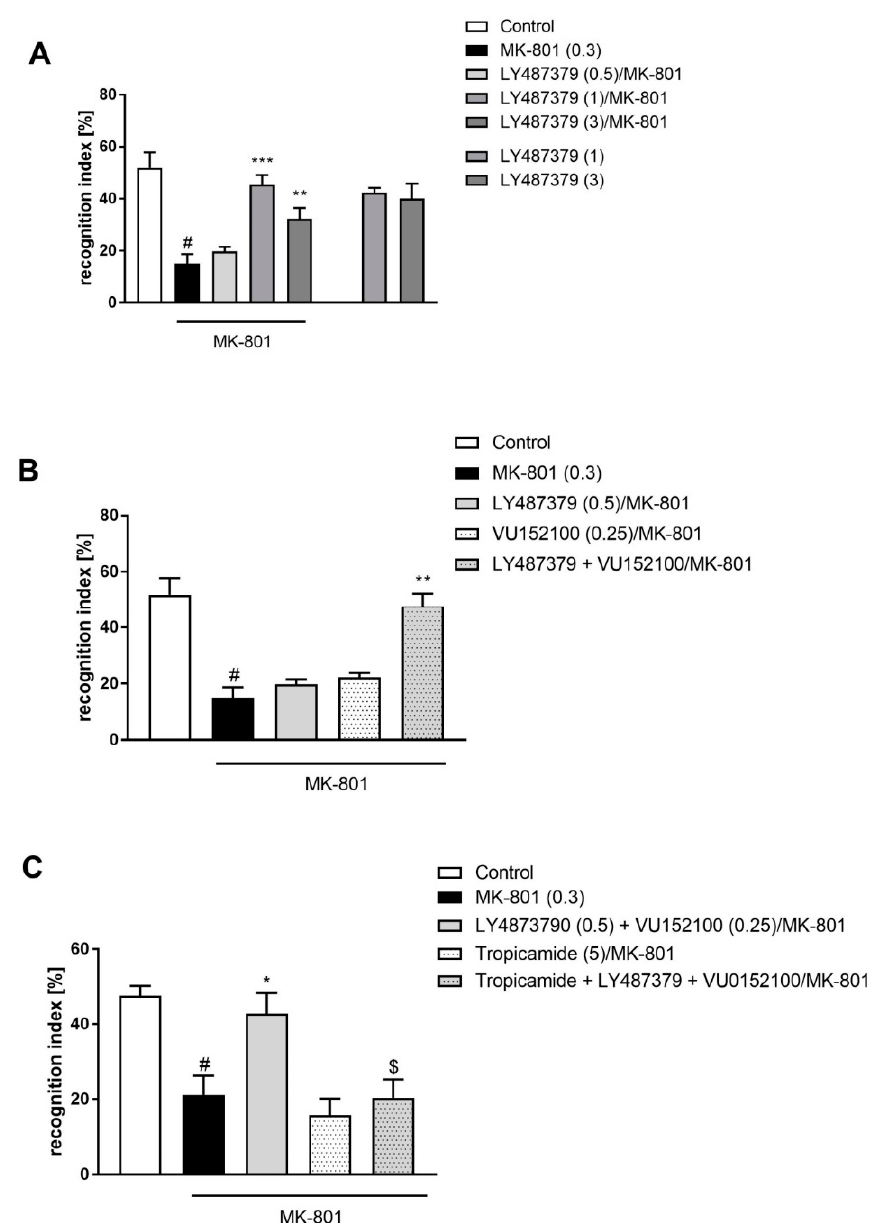
Figure 2. Novel object recognition test in mice. Effectivity of LY487379 ( A ), combined administration of sub-effective doses of LY487379 and VU152100 ( B ), and the blockade of combination’s effect by M 4 receptor antagonist Tropicamide ( C ). Compounds and MK-801 were administered acutely, as shown in Figure 1. Investigated doses are indicated in parentheses. Bars represent the means ± SEM. N = 8–10 / group. # p < 0.001 versus the control group; * p < 0.05 and ** p < 0.01 versus the MK-801-treated group; $ p < 0.0001 versus the LY487379 + VU152100